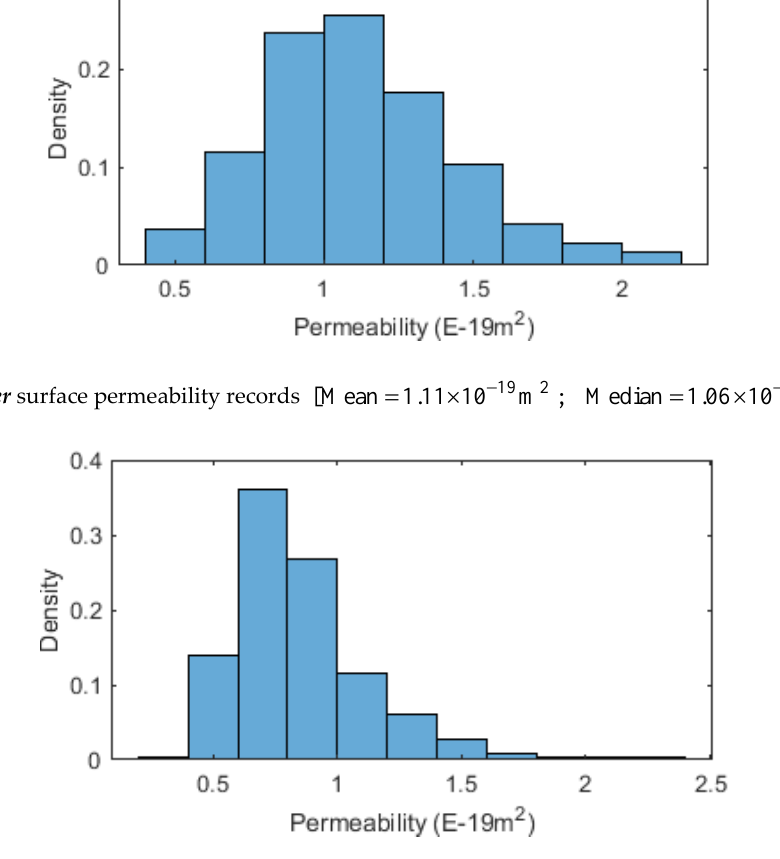
Figure 18. Spatial permeability probability density histogram for the Lac du Bonnet granite derived using the kriging procedure on the Higher and Lower surface permeability records.